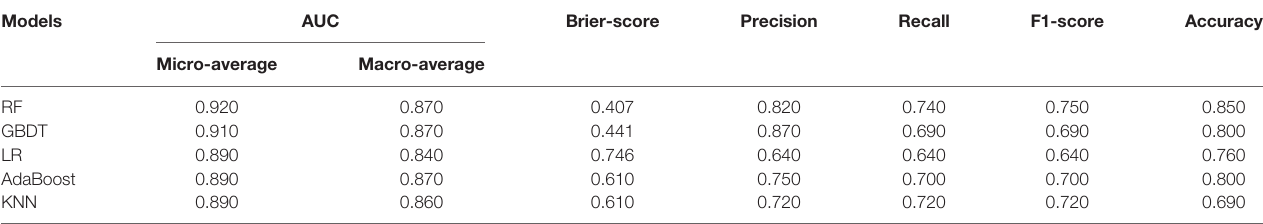
TABLE 1 | Results obtained by different ML